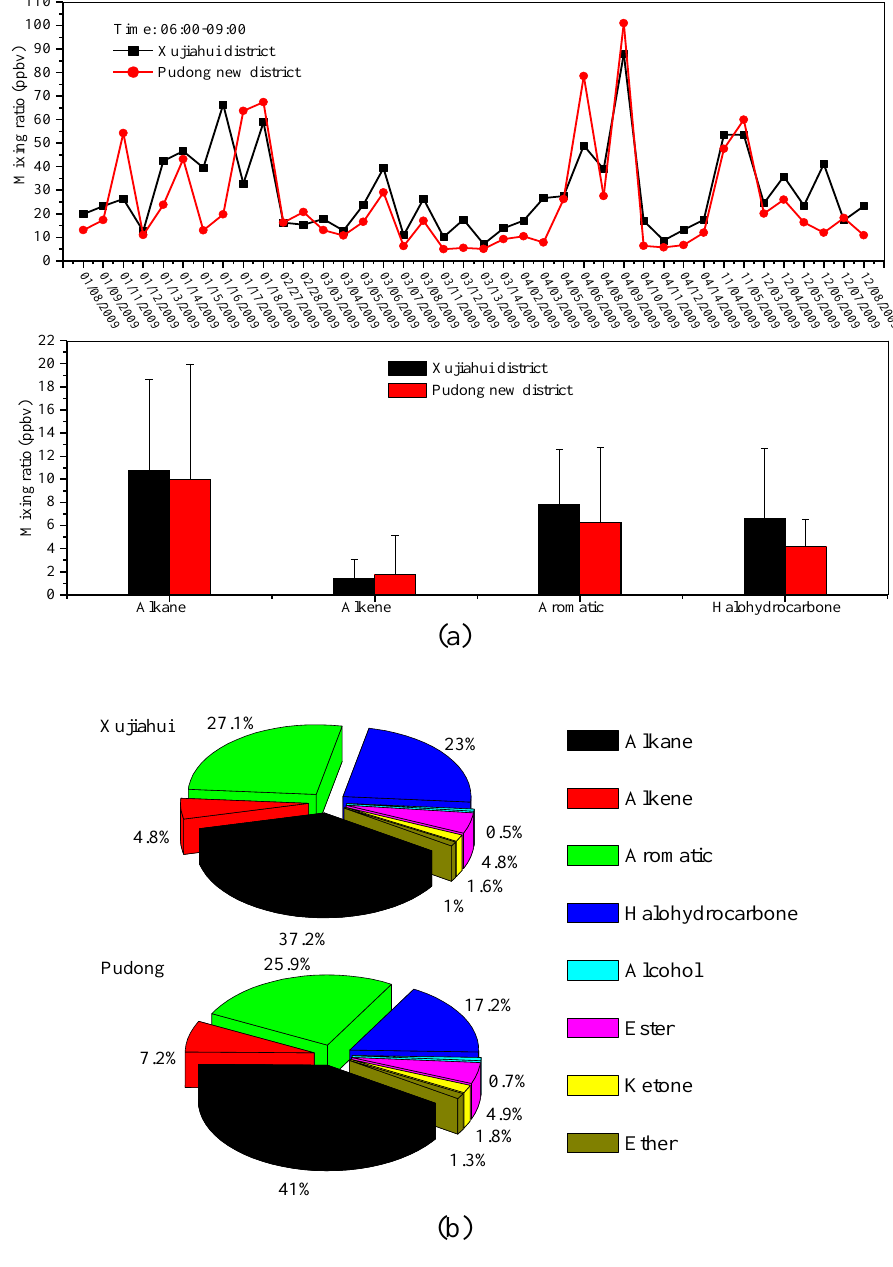
Figure 5. (a) Comparison of the total VOC concentrations in the morning (06:00–09:00) at two sampling sites (Xujiahui and Pudong) during 2009; (b) The measured VOC in the morning (06:00–09:00) for different VOC groups (alkanes, alkenes, aromatics, halohydrocarbons, alcohols, esters, ketones, and ethers) at two sampling sites (Xujiahui and Pudong) during 2009.